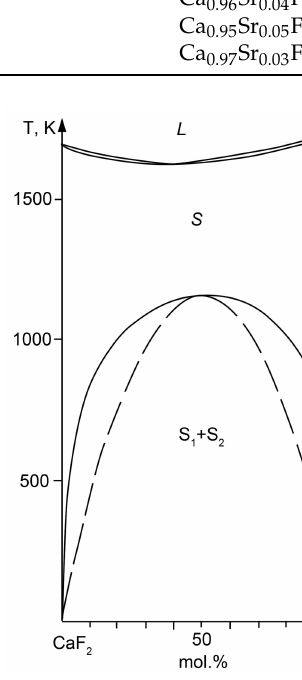
Figure 11. Phase diagram of the CaF 2 –SrF 2 system [72]: melt (L), Ca 1 − x Sr x F 2 solid solution (S); spinodal is shown as a dashed